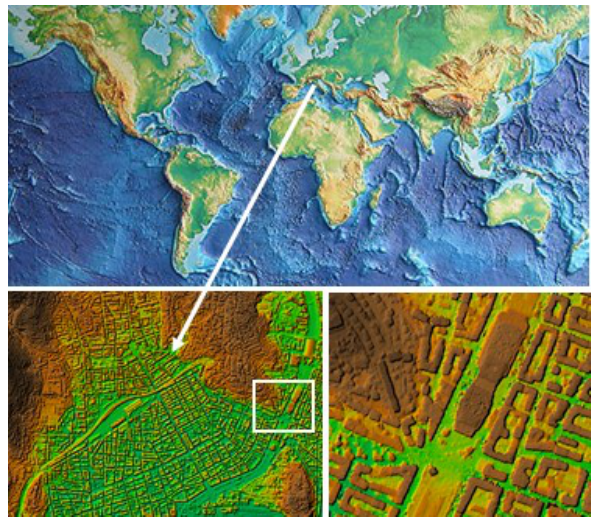
Figure 1. A one-meter accuracy worldwide DEM of landmasses between S60° and